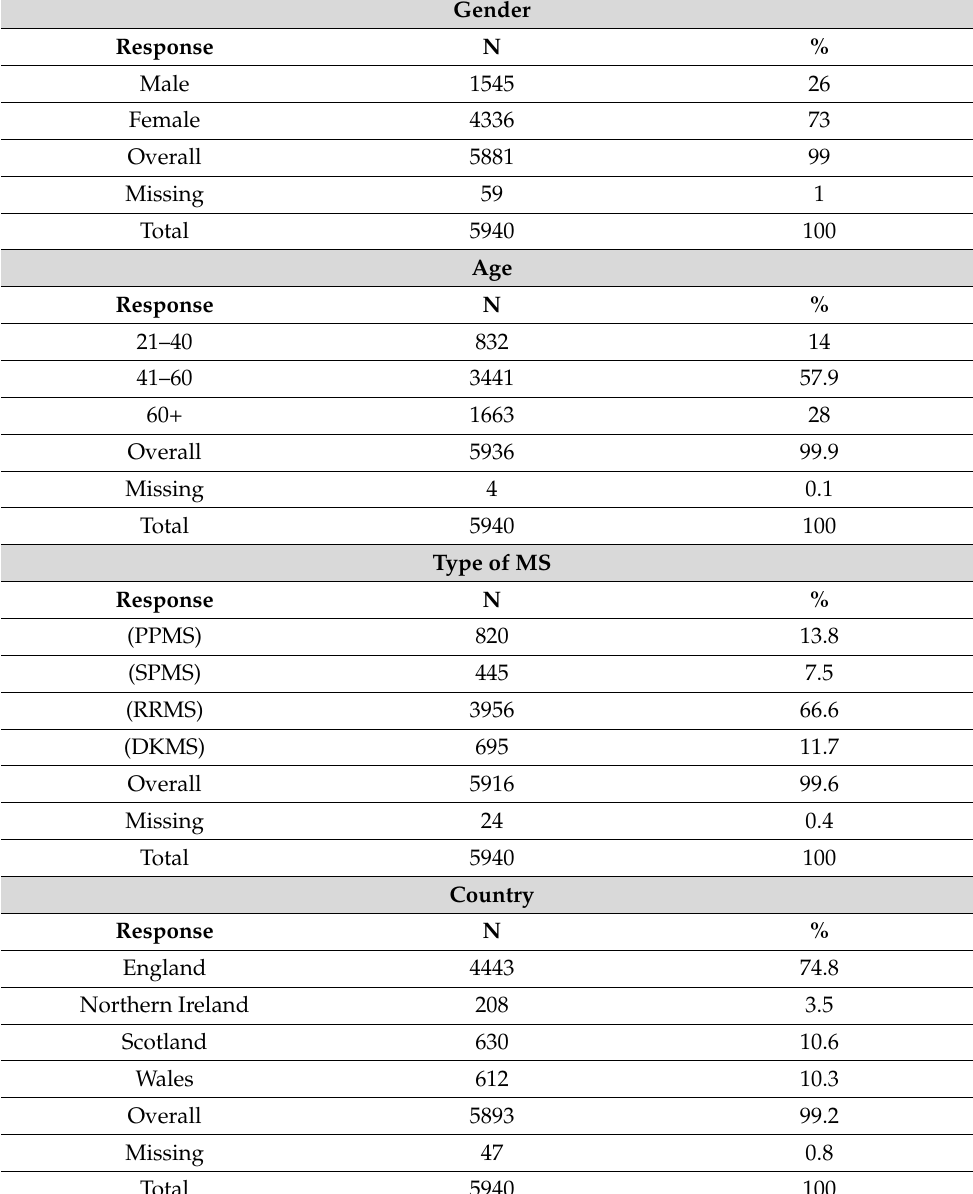
Table 1. Statistics of demographic of the UK MS register population.